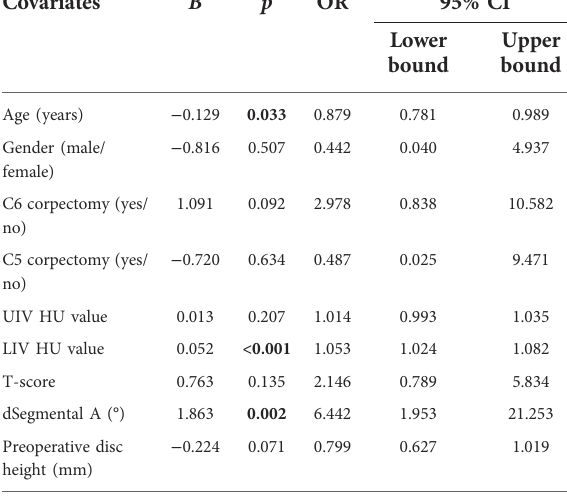
TABLE 5 Results of multivariate logistic